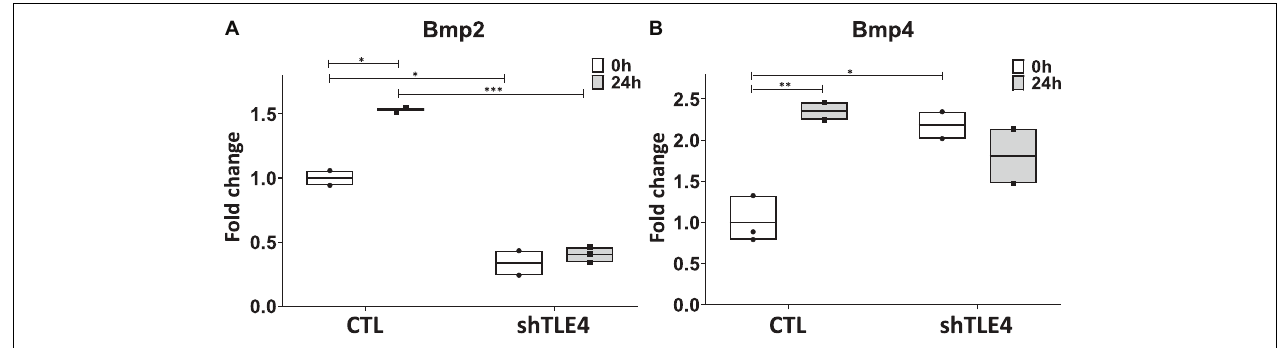
FIGURE 5 | Tle4 knockdown in ST2D cells cause aberrant levels of Bmp2 and Bmp4 expression in response to Runx2 expression. (A) Twenty-four hours after Runx2 induction, upregulation of Bmp2 in control (CTL) cells. Knockdown of Tle4 represses Bmp2 expression and blocks upregulation with Runx2 induction. (B) Induction of Runx2 also leads to an upregulation of Bmp4 in control cells. This upregulation is not seen in the presence of Tle4 knockdown ( n = 3 biologic replicates per arm, technical triplicates; * p < 0.05, ** p < 0.01, *** p < 0.001, and Student t